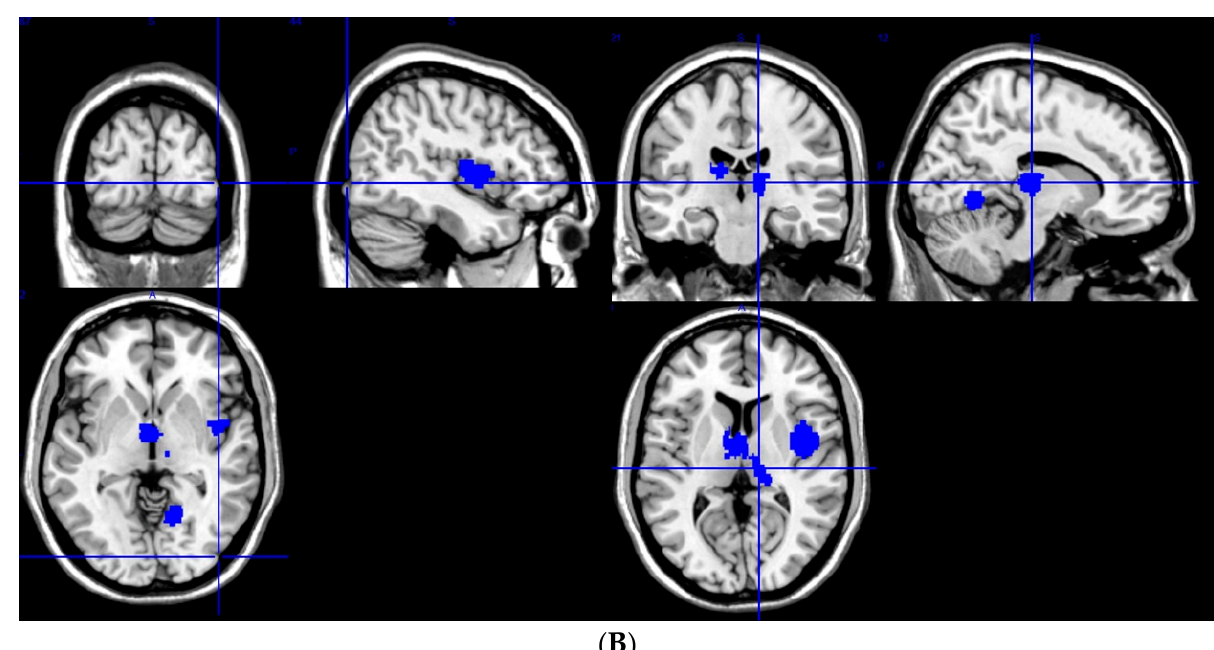
Figure 2. ( A ) Areas with increased gray matter volume in JME patients and ( B ) areas with decreased gray matter volume in JME patients compared to controls.